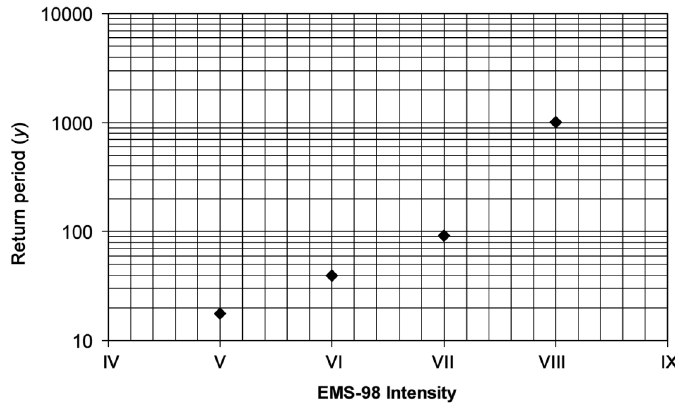
Fig. 6. Estimated return periods, following the methodology of Magri et al.